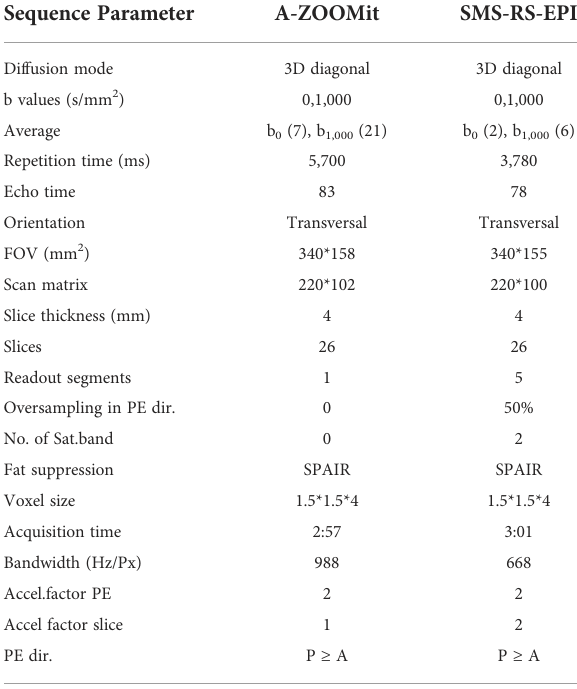
TABLE 1 Sequence parameters for advanced ZOOMit (A-ZOOMit) and simultaneous multislice readout segmented echo-planar imaging (SMS-RS-EPI